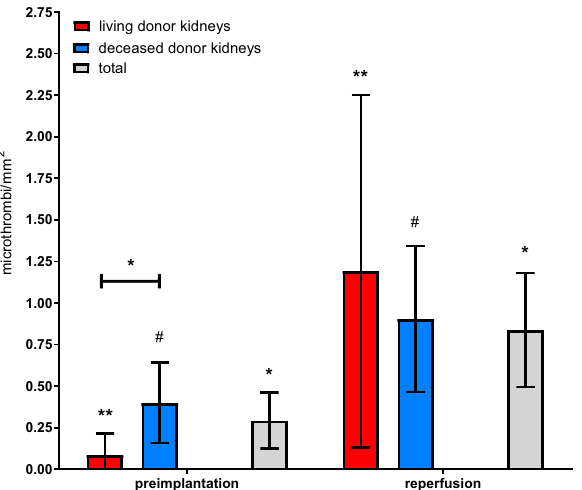
Figure 4. Number of microthrombi/mm 2 . Data is shown as mean with 95% confidence interval. microthrombi/ mm 2 , microthrombi per square millimeter; *p = 0.02; **p = 0.03; #p =